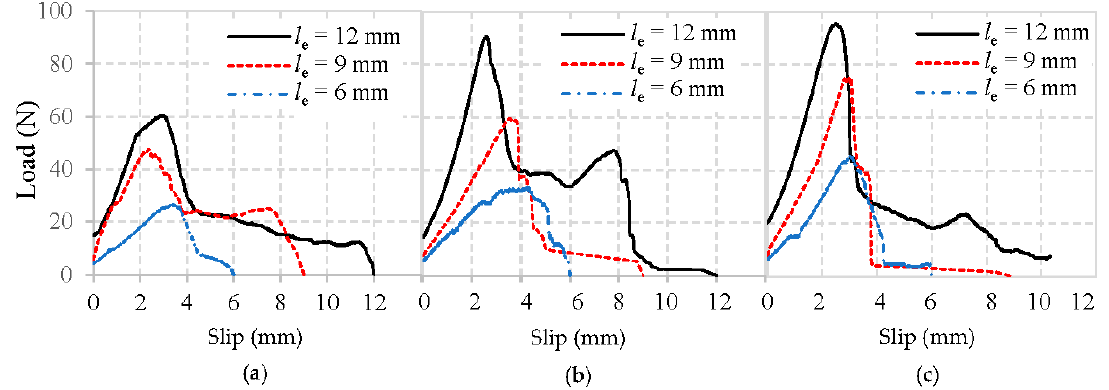
Figure 10. Load–slip curves of PVA fibers pulled out from the mortar matrix: ( a ) W / C = 0.65, ( b ) W / C = 0.49, and ( c ) W / C = 0.40.